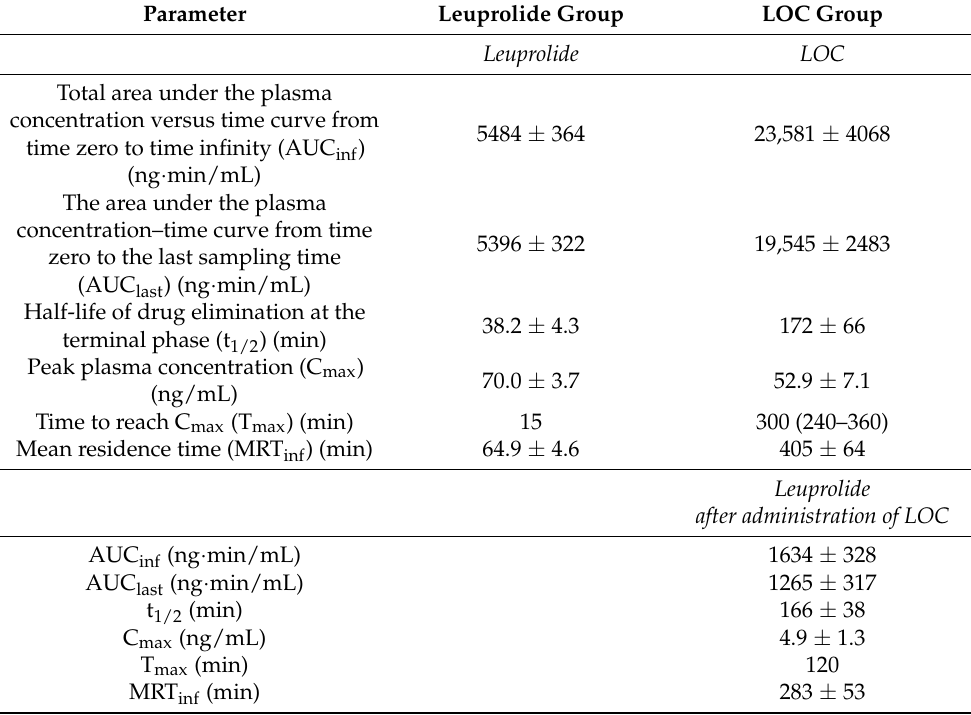
Figure 4. Arterial plasma concentration versus time profiles of the LOC and leuprolide (as a metabolite of the LOC) following the subcutaneous administration of the LOC in rats. The open and closed circles and their error bars represent the mean and standard deviation values, respectively ( n = 4). Table 3. Pharmacokinetic parameters of leuprolide and the LOC following their subcutaneous injection in rats ( n =